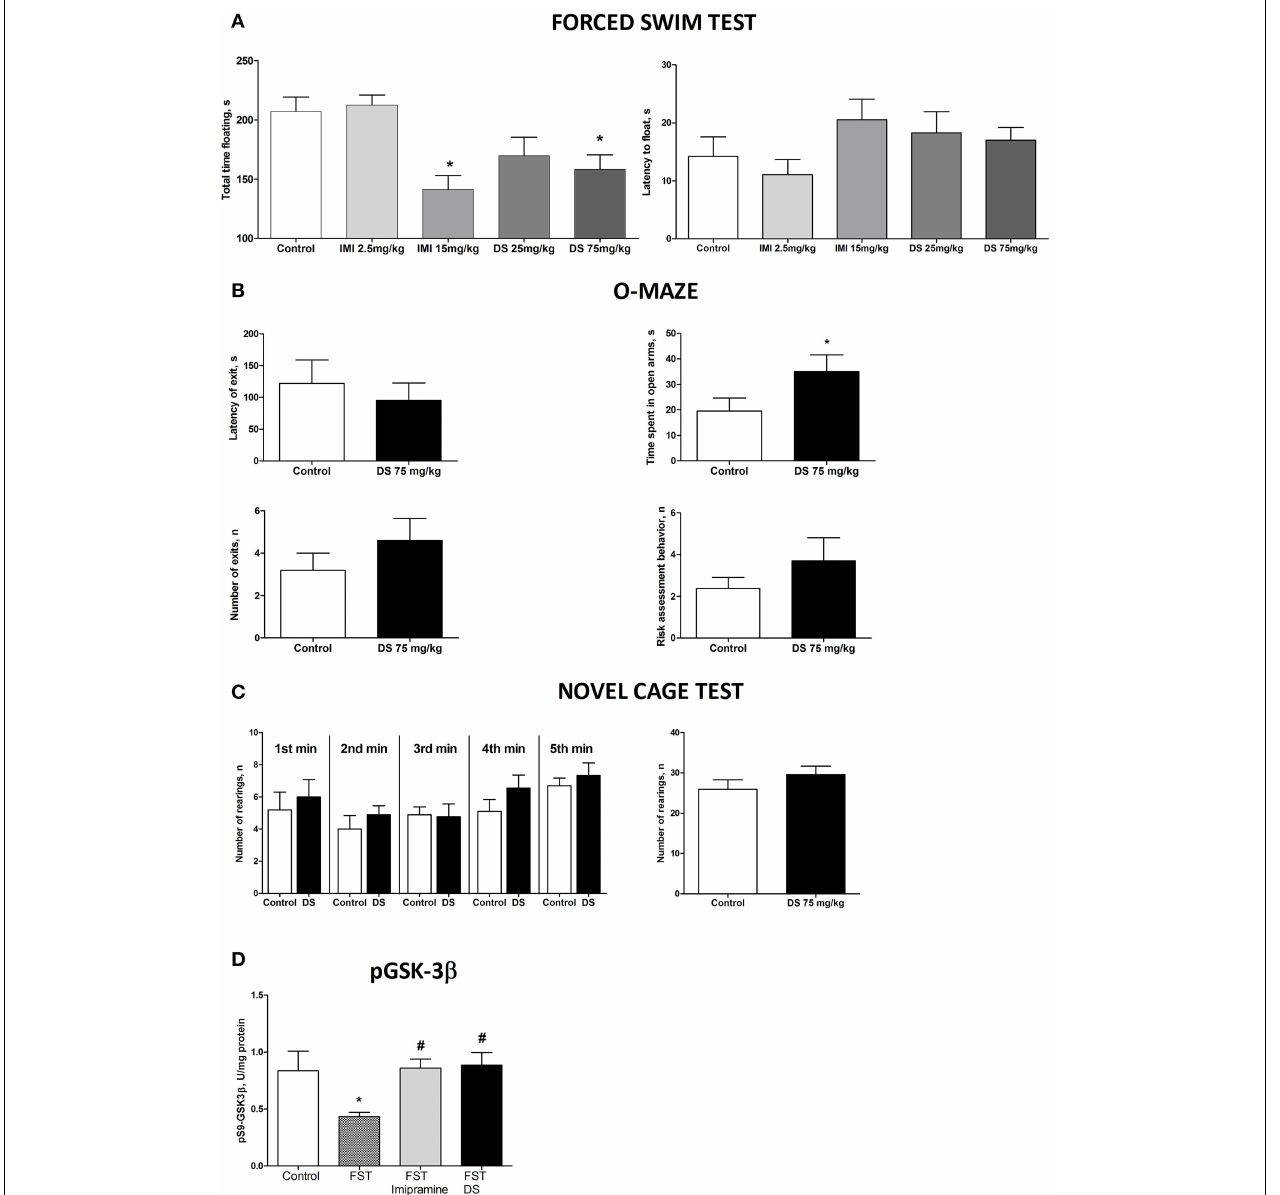
FIGURE 5 | Study of the effects of Dicholine Succinate in naïve mice. (A) No differences were observed in the latency to float for any group ( p > 0 . 05) while there was a significant effect of total time spent floating ( p < 0 . 005). Tukey’s revealed that groups receiving higher treatment does had significantly less floating ( p < 0 . 01, imipramine and p < 0 . 05, DS). (B) In the elevated O-maze test mice treated with a dose of 75mg/kg/day of dicholine succinate, displayed significantly longer duration in the open arms, with no significant changes to a latency to exit, total number of exits, or risk assessment behavior in comparison with control animals ( p < 0 . 05). (C) No changes were observed between DS treated animals and controls at any time point